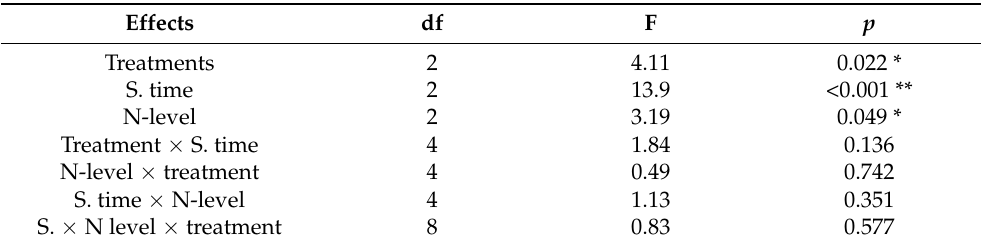
Table 3. The results of repeated ANOVA of the effect of tillage treatments (NT, RT and CT), sampling time (April 2019, August 2019 and March 2020), N levels and their interaction on the abundance of